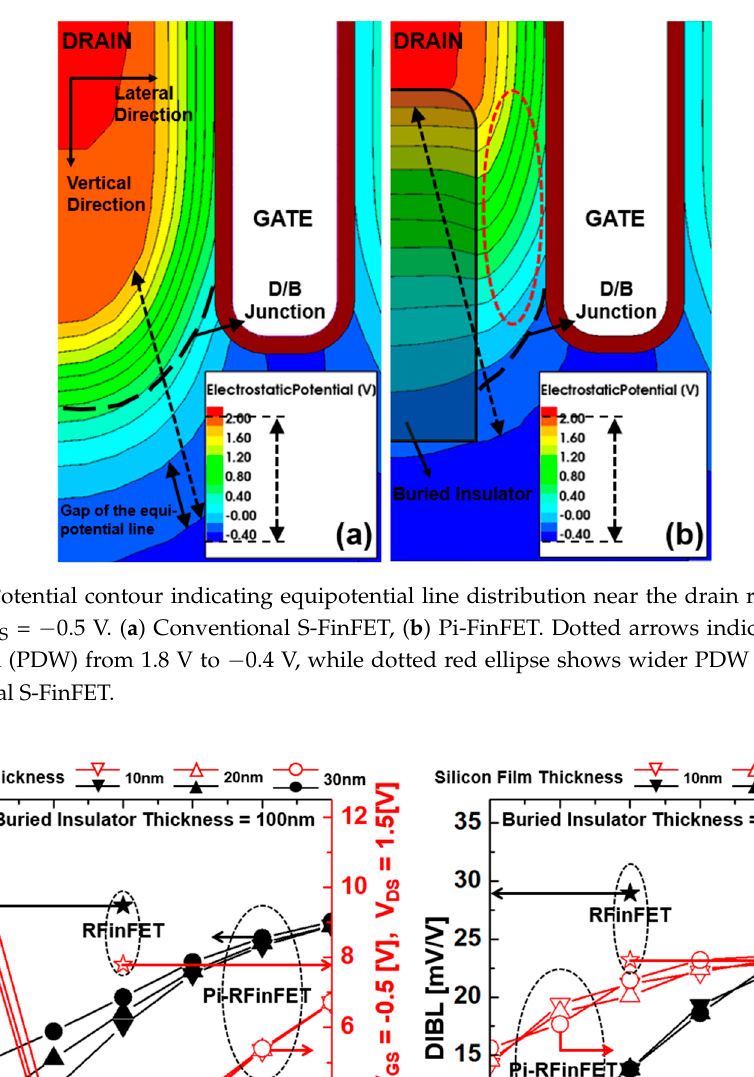
Figure 5. ( a ) I off (V GS = − 0.5 V, V DS = 1.5 V) and ( b ) DIBL (V DS.low = 0.05 V, V DS.high = 1.5 V) dependence on L g of conventional S ‐ FinFETs and Pi ‐ FinFETs.